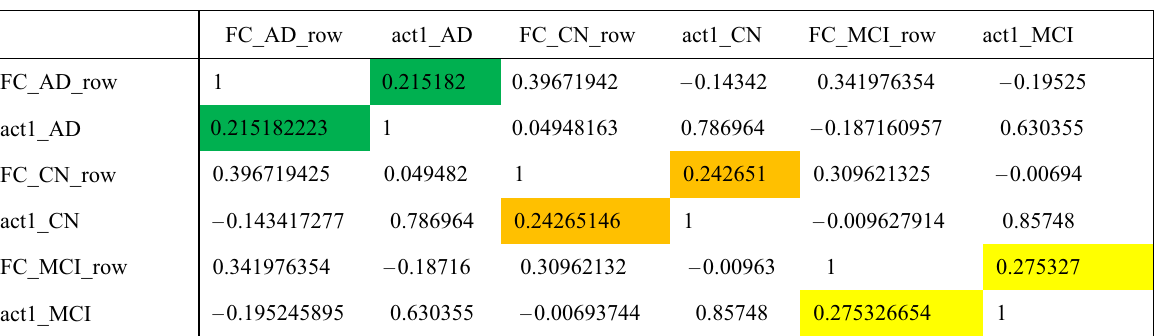
Figure 10. Final FCL 1728 weights plots of trained gamma4_adam network corresponding to each class label. Here FC_AD_row represents the final weights of the layer from the fully trained gamma4_adam network belonging to the AD class, similarly, FC_CN_row and FC_MCI_row represent for CN and MCI categories respectively. While the plots of act1_AD are the weights calculated for a typical AD categorized MRI, obtained using the trained model during the testing phase. So, are the weights calculated as act1_CN and act_MCI for a CN and MCI categorized MRI during testing respectively. This plot is to show how closely the test sample (act1_ xx) follows its parent class characteristics (FC_xx_row). Furthermore, to evaluate this characteristic a correlation table is calculated as in Table 5, where it is very clear that the test sample weights (act1_xx) have the highest correlation with its parent class (FC_xx_row) where xx represents the same class for both sample and parent. The same class high correlation between FC_xx_row and act_xx shows that the network is learning class-wise property precisely. FC_AD_row act1_AD